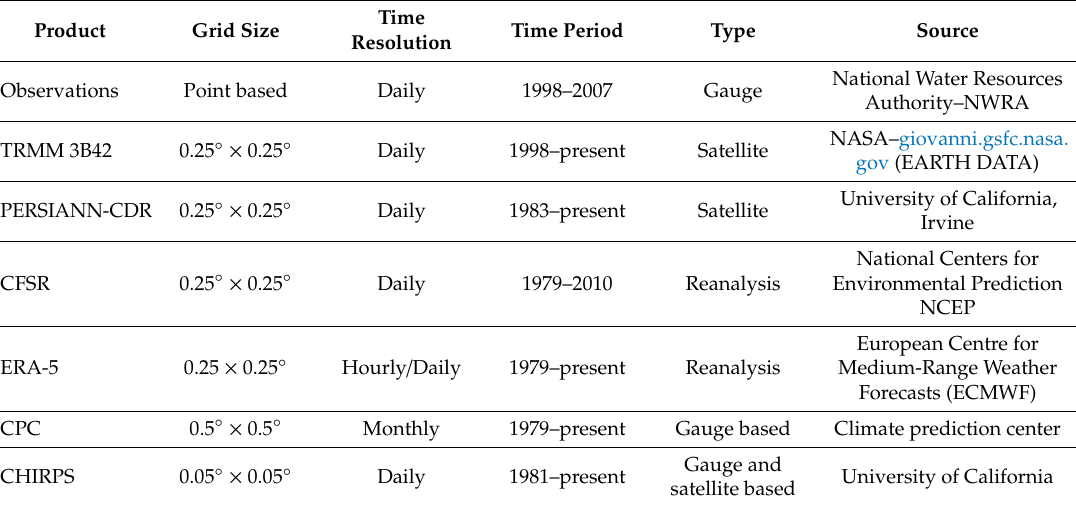
Table 2. General characteristics of the precipitation